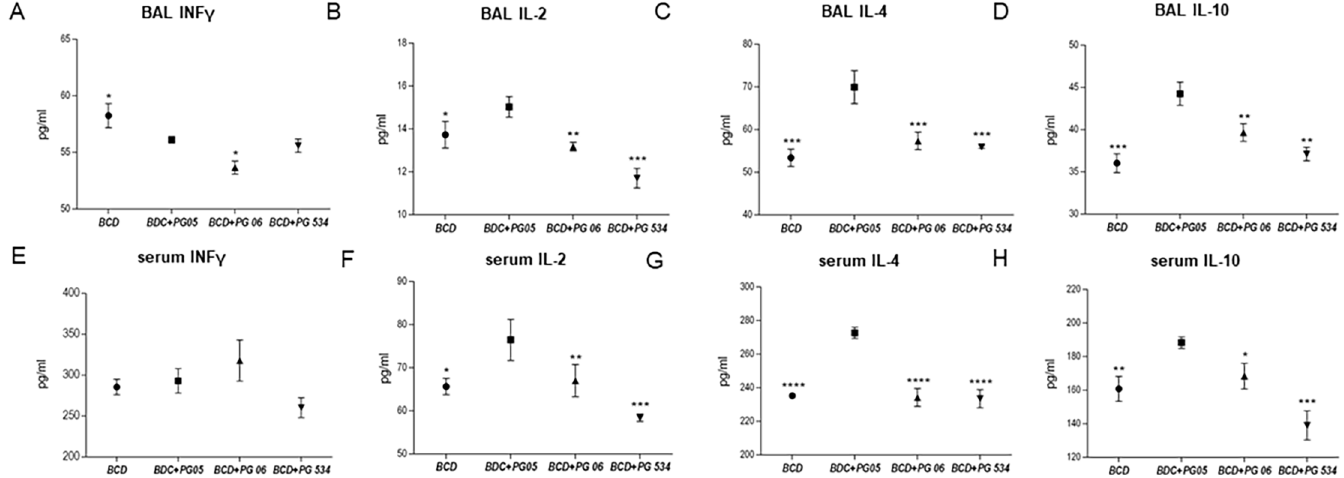
Fig 6. Effect of lactobacilli peptidoglycans on Th1 and Th2 cytokines production after Streptococcuspneumoniae infection in malnourished mice. Immunocompromised-malnourished mice were replete for 7 days with a balanced conventional diet (BCD) or BCD supplemented with peptidoglycans from Lactobacillus rhamnosus CRL1505 (BCD+PG05), L . plantarum CRL1506 (BCD+PG06) or L . rhamnosus CRL534 (BCD+PG534), and then challenged with S . pneumoniae . The levels of cytokines were studied ten days after the pneumococcal challenge. (A-D) Broncho-alveolar lavages (BAL), and (E-H) serum concentration of INF- γ , IL-2, IL-4, and IL-10. Results represent data from three independent experiments. Results are expressed as mean ± SD. Asterisks represent statistical differences compared with BCD+PG05 group. (cid:3) p < 0.05, (cid:3)(cid:3) p < 0.005, (cid:3)(cid:3)(cid:3) / (cid:3)(cid:3)(cid:3)(cid:3) p (cid:20) 0.001.